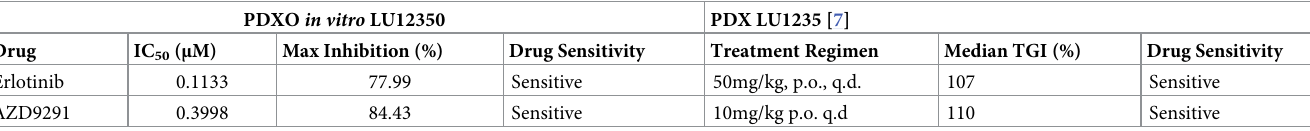
regression that was observed in PDX in vivo testing for erlotinib [7] and AZD9291 (unpub- lished data). In comparison, PDXO-LU2512, which does not carry an EGFR activation muta- tion, showed poor response to erlotinib (IC > 20 μ M, Fig 3c) similar to its parental PDX 50 model (TGI < 20%). In addition, SOC cisplatin induced an IC of 8.8 μ m in PDXO-LU2512 50 Table 2. Correlation of NSCLC LU1235 PDXO and PDX